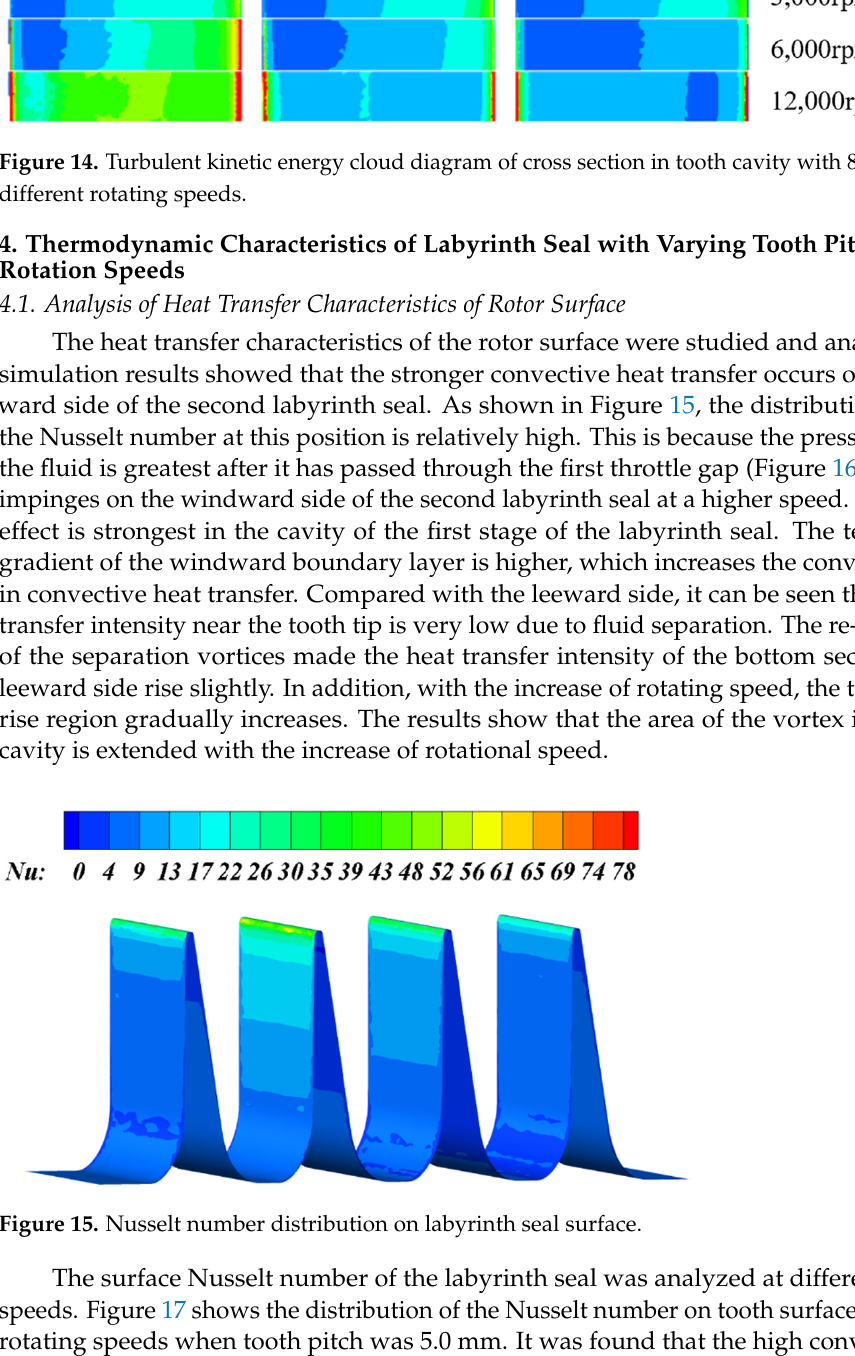
Figure 14. Turbulent kinetic energy cloud diagram of cross section in tooth cavity with 8 mm pitch at different rotating speeds.